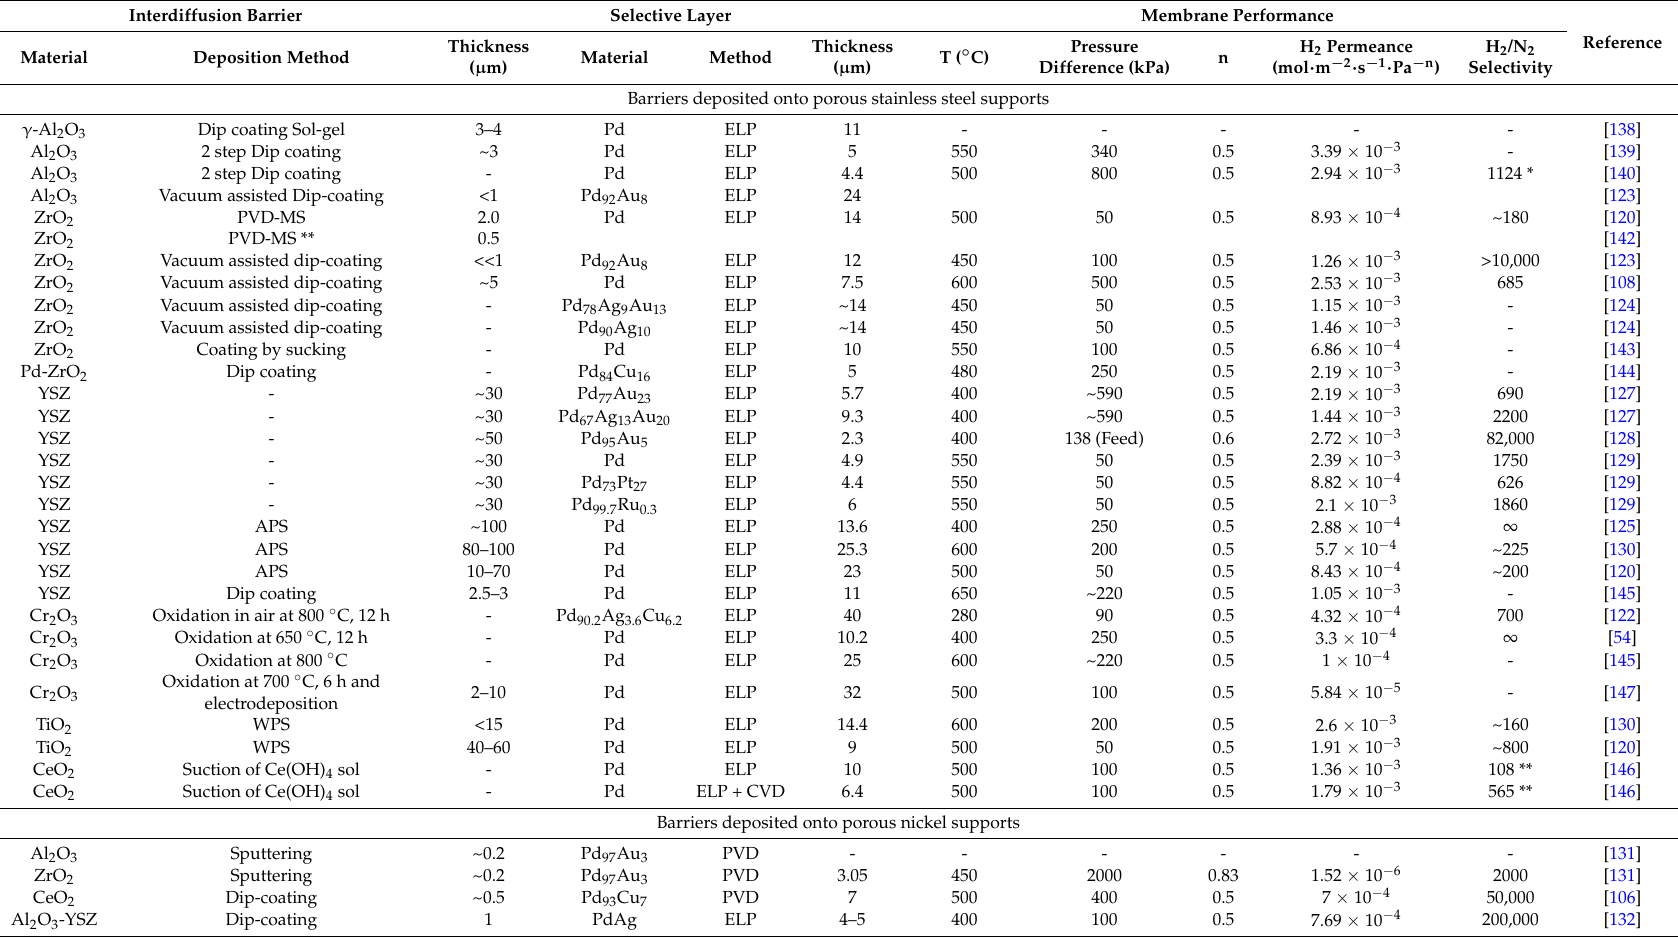
Table 8. Pd-based layers deposited onto modified metallic supports with different interdiffusion